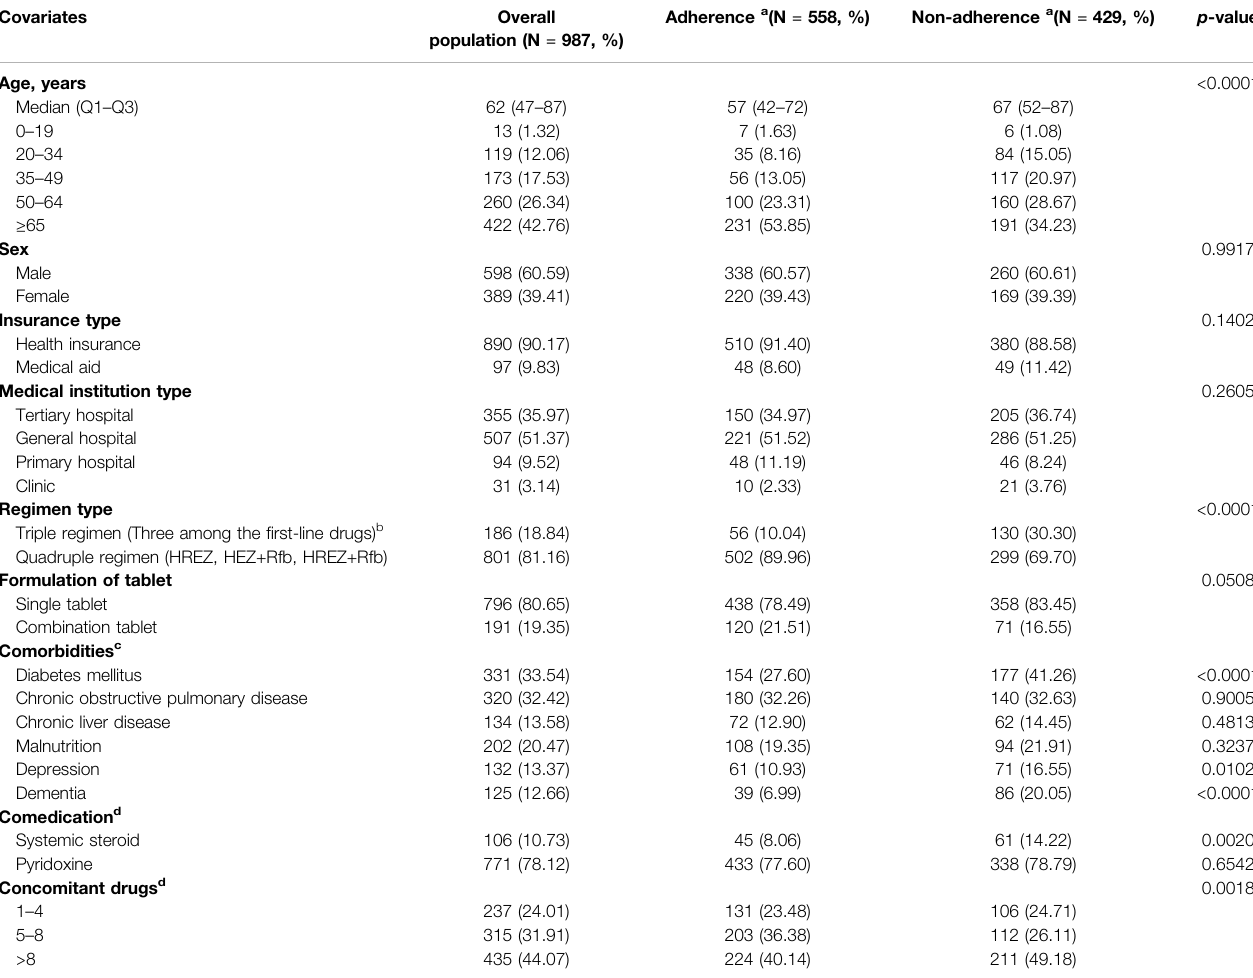
TABLE 1 | Demographic characteristic of the patients receiving tuberculosis drugs by adherence status in 2017 – 2018. Covariates Overall population (N = 987,